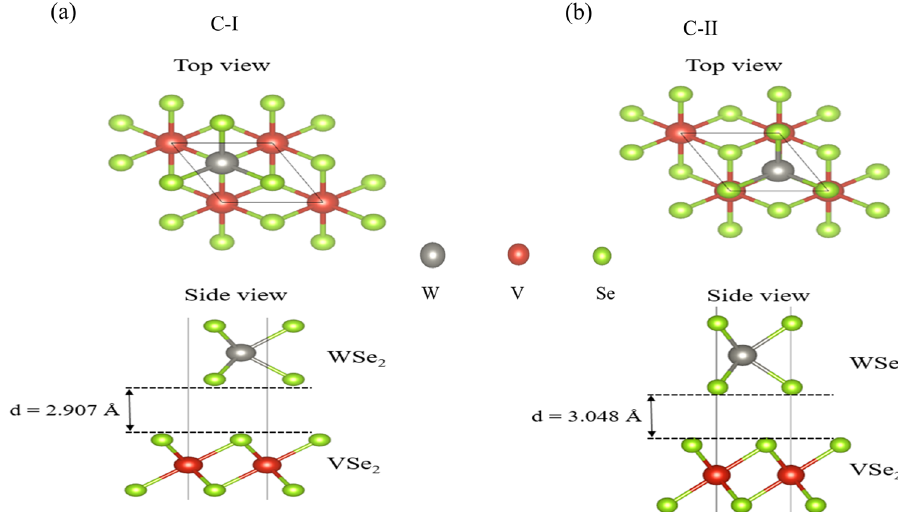
Fig. 2 Stackings illustrations of the WSe2/VSe2 heterostructure. Top and side views of the WSe 2 /VSe 2 heterostructure for a C-I stacking and b C-II